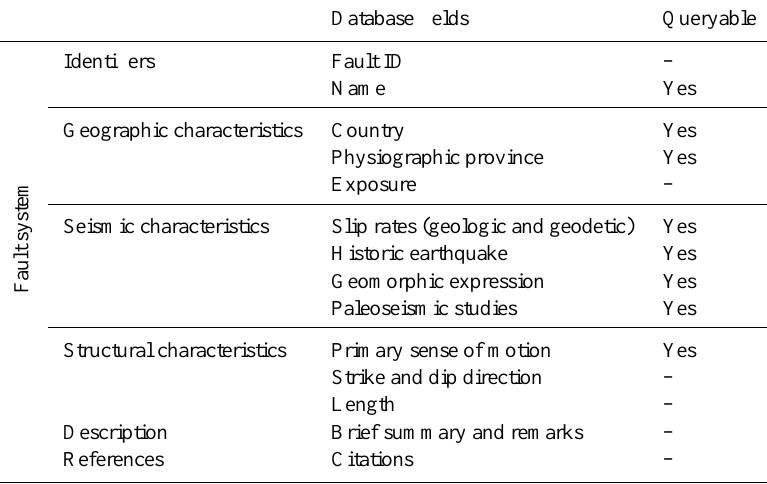
Table 2. Structure of the CAFD and queryable search